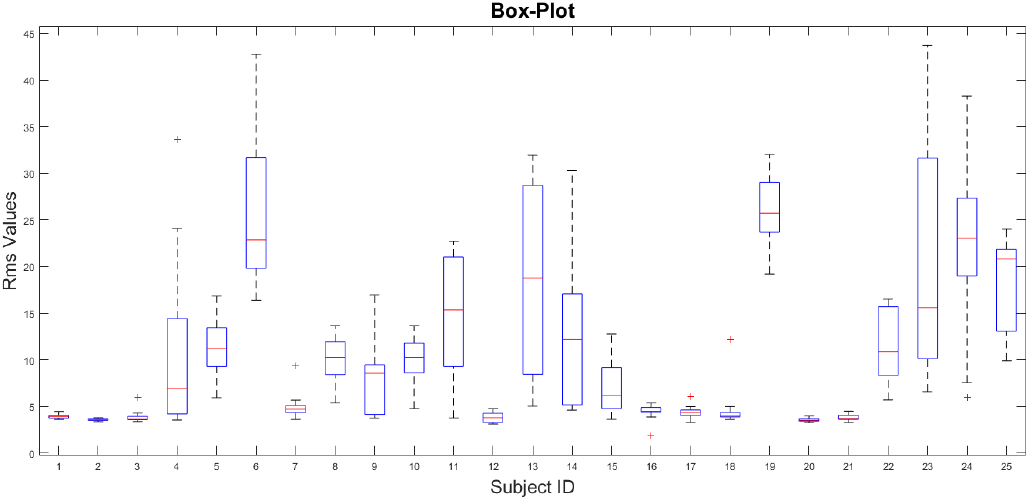
Figure 10. Box-plot representation for all the 25 subjects from Table